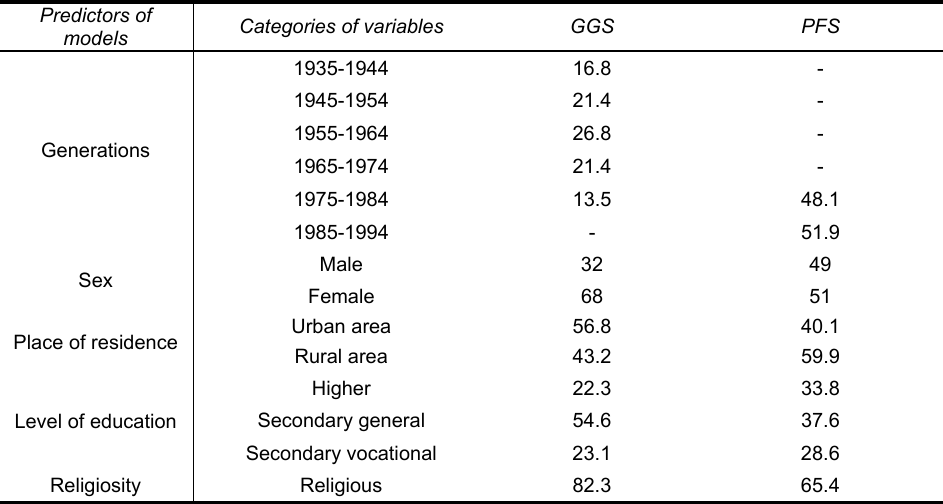
Table 3. The relative number of observations for the predictors of the first group of models,